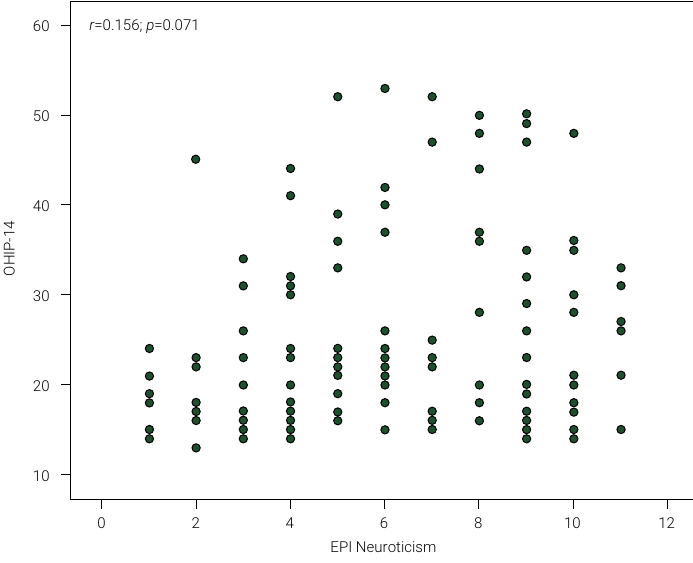
Figure 6. Ratio between Neuroticism and OHIP-14 test results (r=0.156; p =0.071).